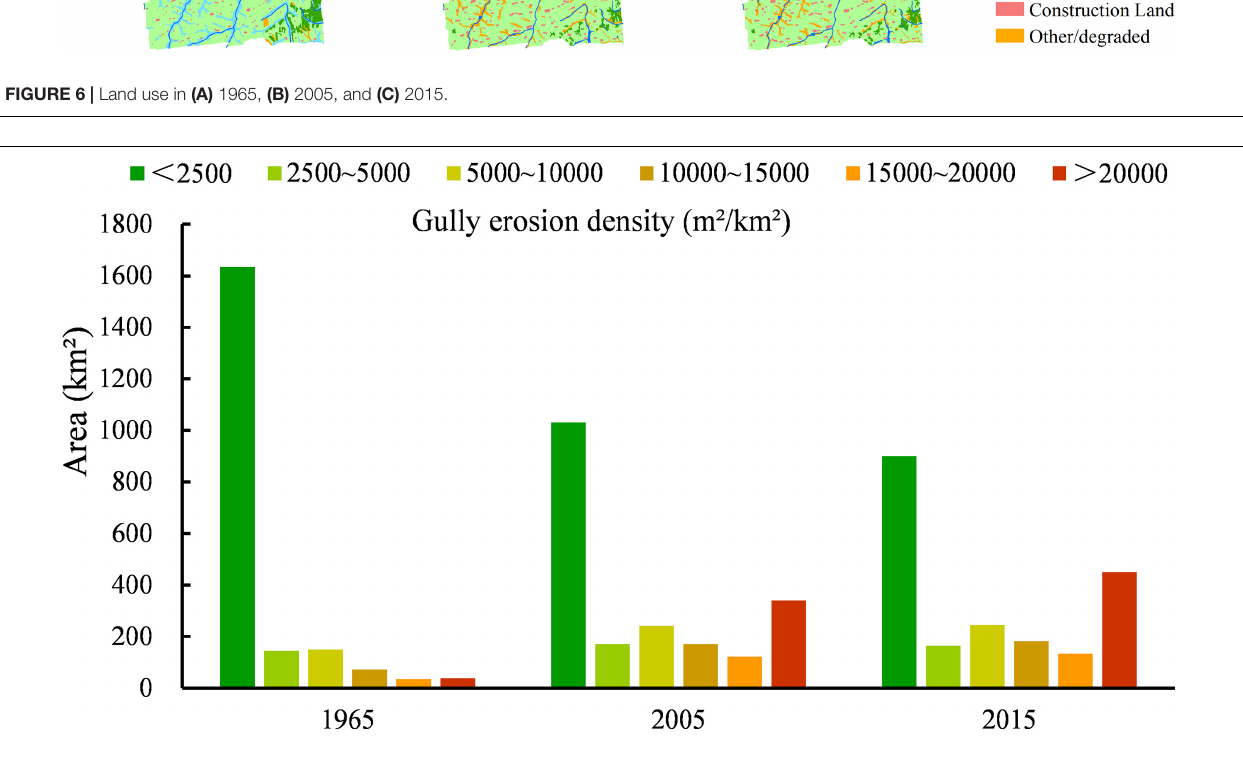
FIGURE 7 | Gully density changes 1965 to